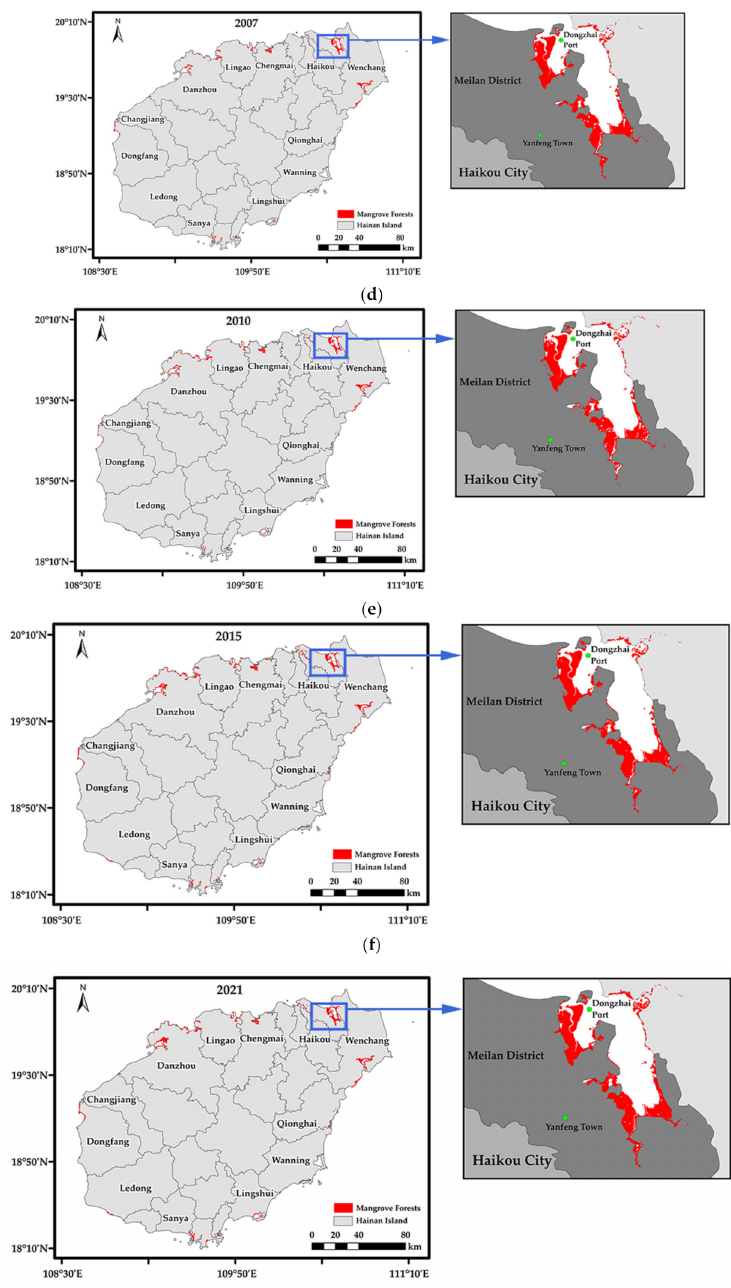
Figure A1. SVM machine-learning classification results. ( a ) 1991; ( b ) 1996; ( c ) 2000; ( d ) 2007; ( e ) 2010; ( f ) 2015; ( g )